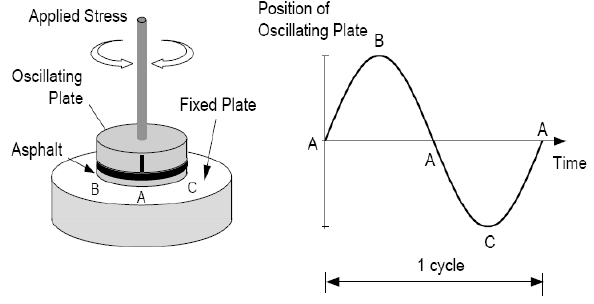
Figure 5. DSR test